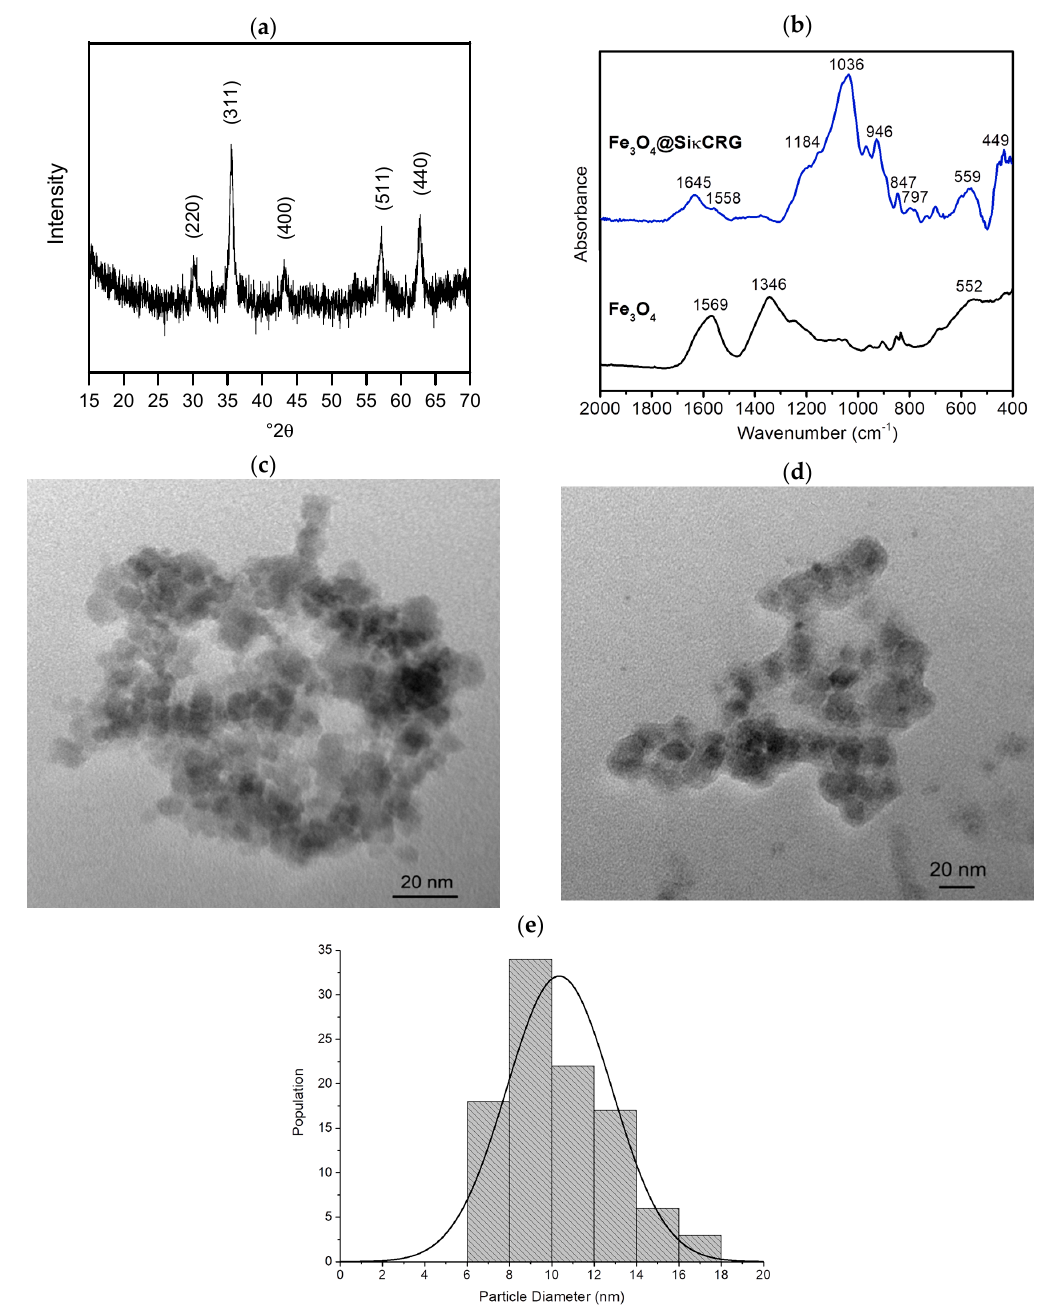
Figure 1. Physicochemical characterization of nanoparticles. ( a ) XRD diffraction pattern, with Bragg reflections identified. ( b ) ATR-FTIR spectra, with main bands identified. TEM images of Fe 3 O 4 ( c ) and Fe 3 O 4 @Si κ CRG ( d ) nanoparticles. ( e ) Histogram for size distribution of Fe 3 O 4 core nanoparticles.